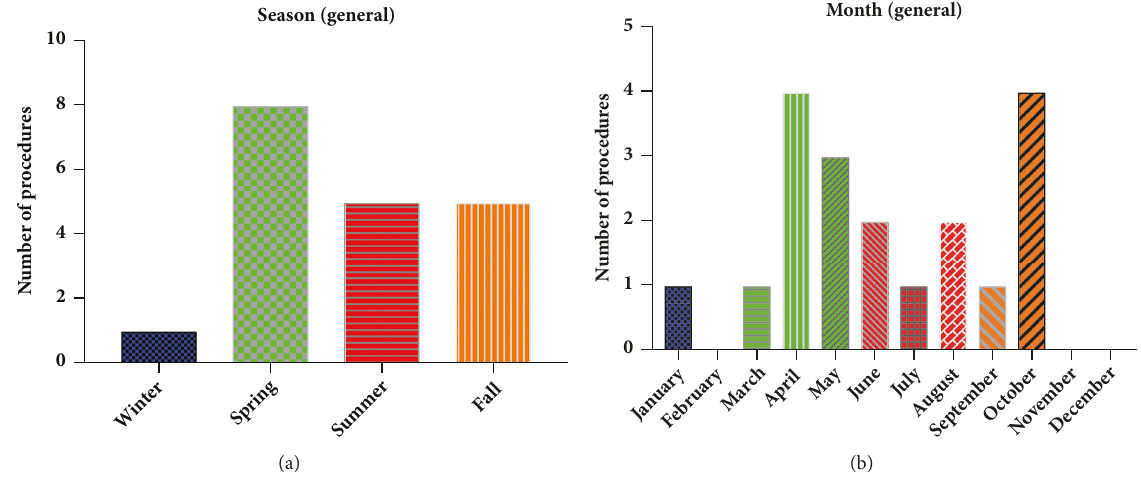
Figure 3: No trends in seasonality nor procedure month at general university hospital. (a) The season during which procedures resulting in PJIs at the general university hospital were performed is shown. (b) The particular month during which procedures resulting in PJIs at the general university hospital were performed is shown, with the months color-coded corresponding to the season.